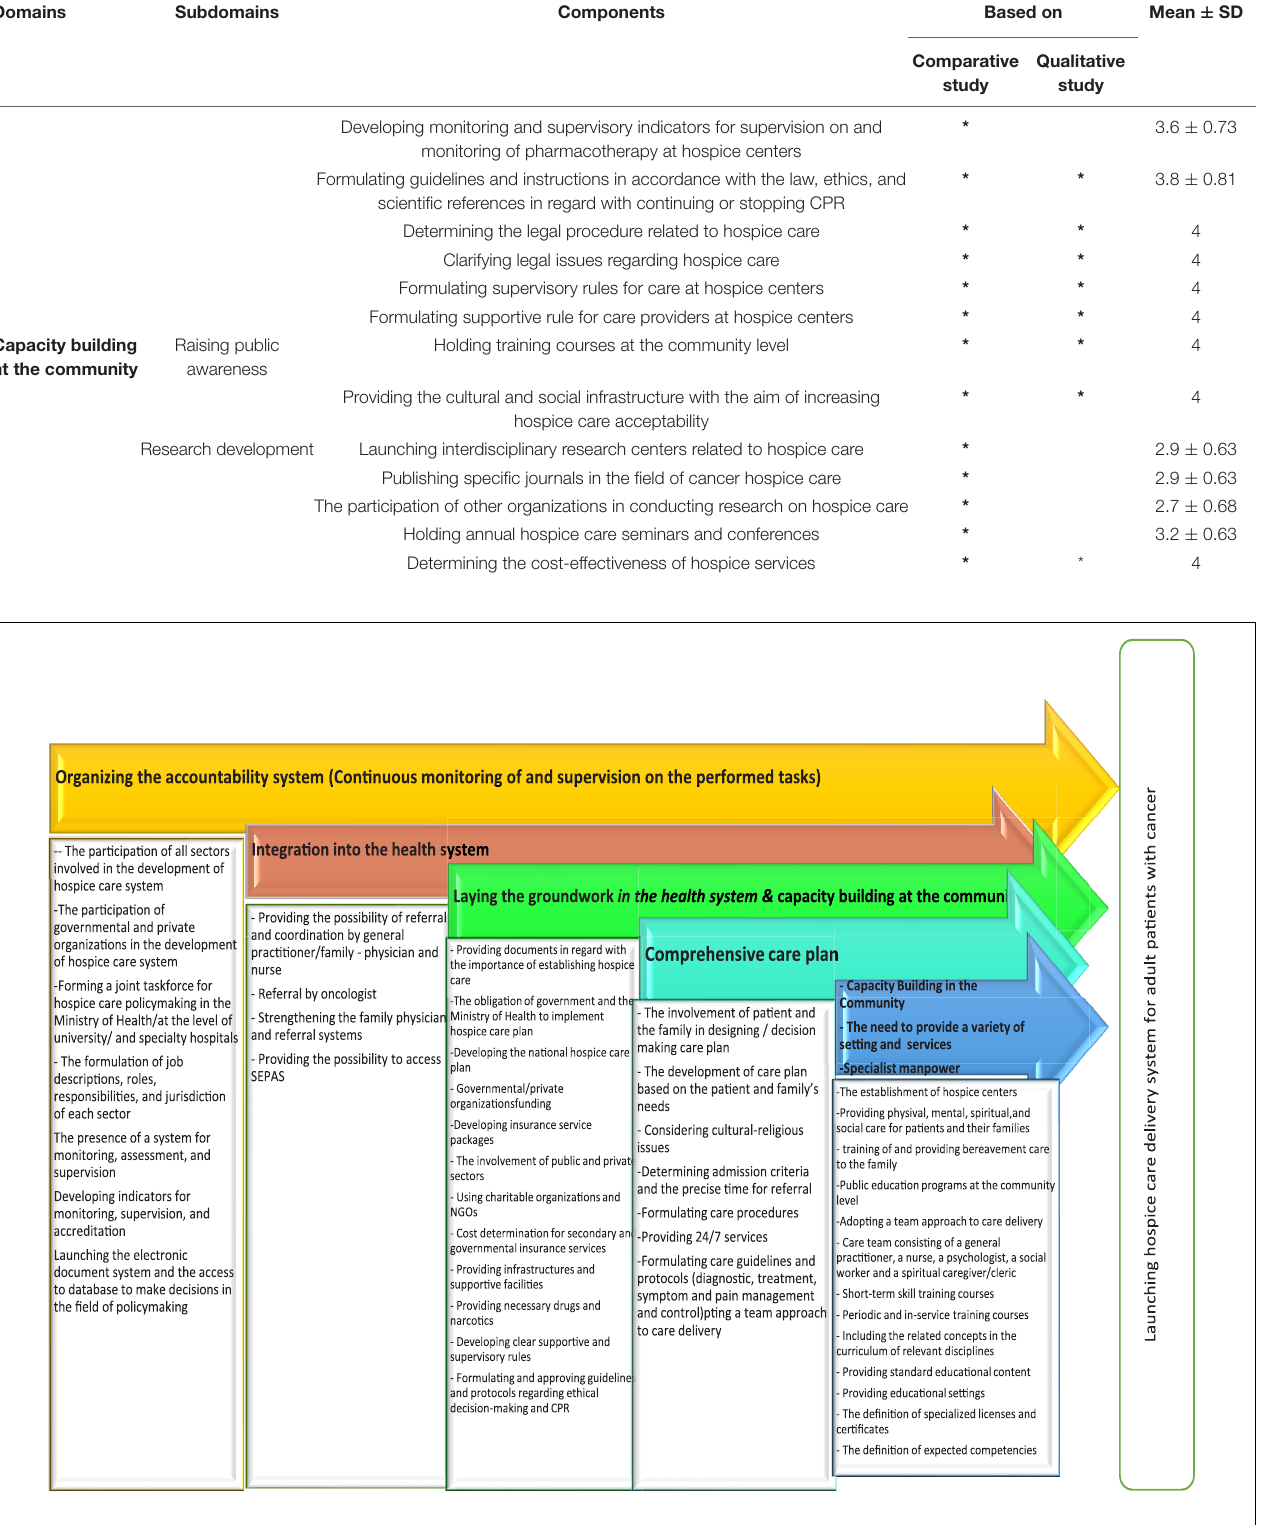
FIGURE 2 | The model for the establishment of hospice care delivery system for adult patients with cancer.